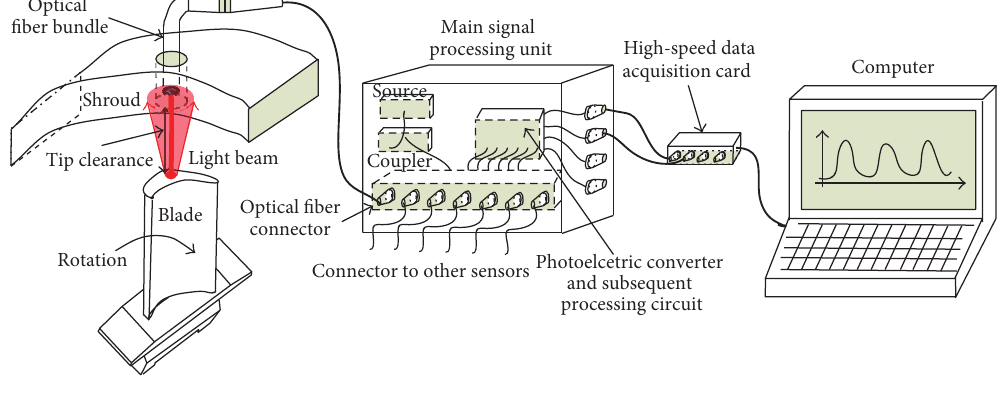
Figure 3: Optical fiber tip clearance measurement